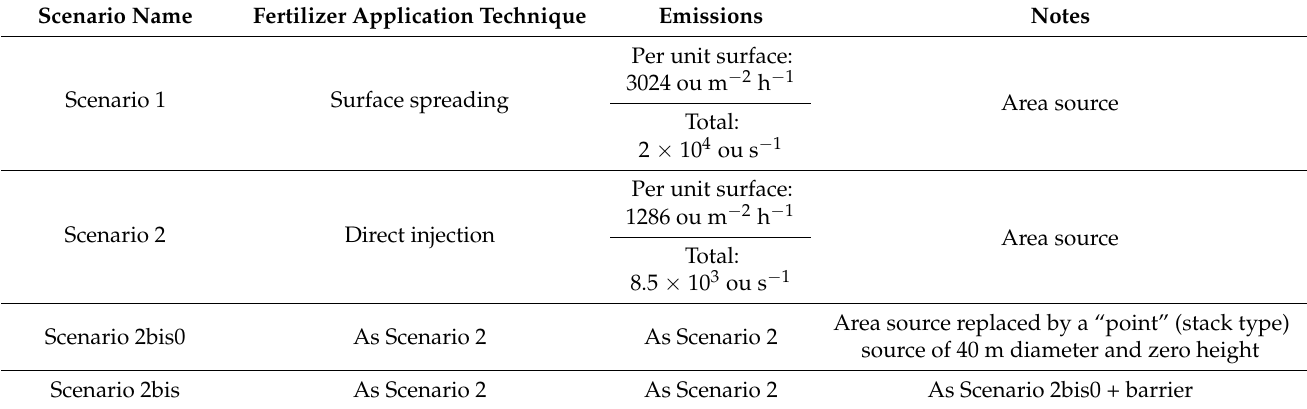
Table 3. Description of the simulation